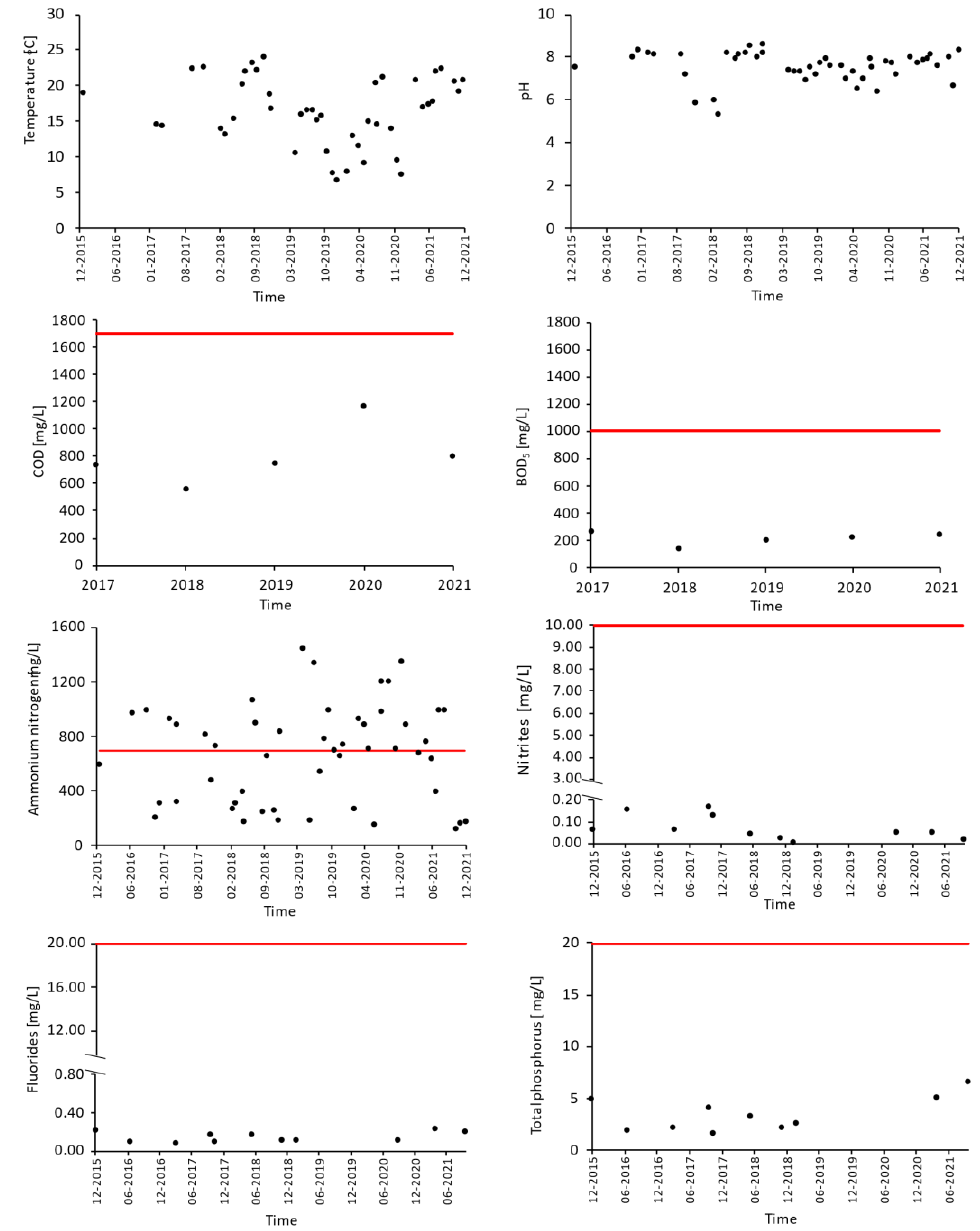
Figure 3. Characteristics of the basic physical parameters of industrial wastewater generated on the ZUOK site in Olsztyn between December 2015 and December 2021. The red line indicates the permissible values as set out in the integrated permit.